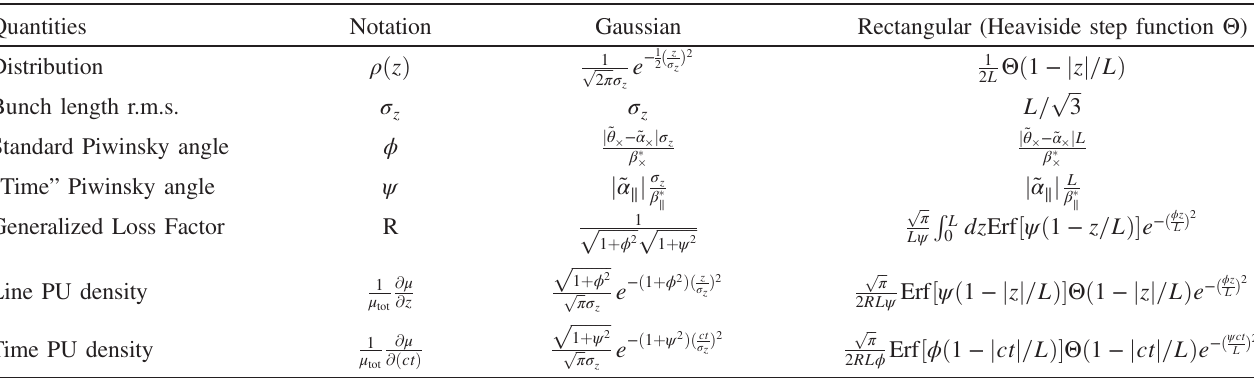
TABLE II. Simplified expressions for the line and time pile up densities in the case of a Gaussian or rectangular bunch distributions